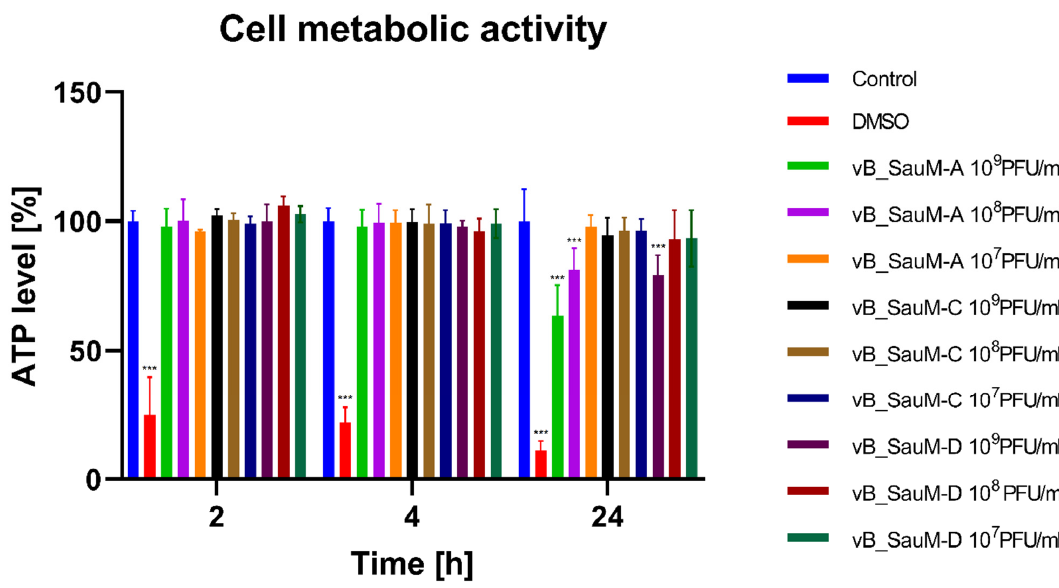
Figure 2. ATP levels of BJ cells treated with phages vB_SauM-A, vB_SauM-C and vB_SauM-D at di ff erent concentrations after 2, 4 and 24 h of incubation in comparison to the untreated negative control (blue) and 10% DMSO-treated positive control (red). Mean values from three independent experiments are shown, with error bars representing SD. Statistical analysis was performed using the Kruskal–Wallis test followed by Dunn’s multiple comparison test for values with nonparametric distribution, with *** p < 0.001.